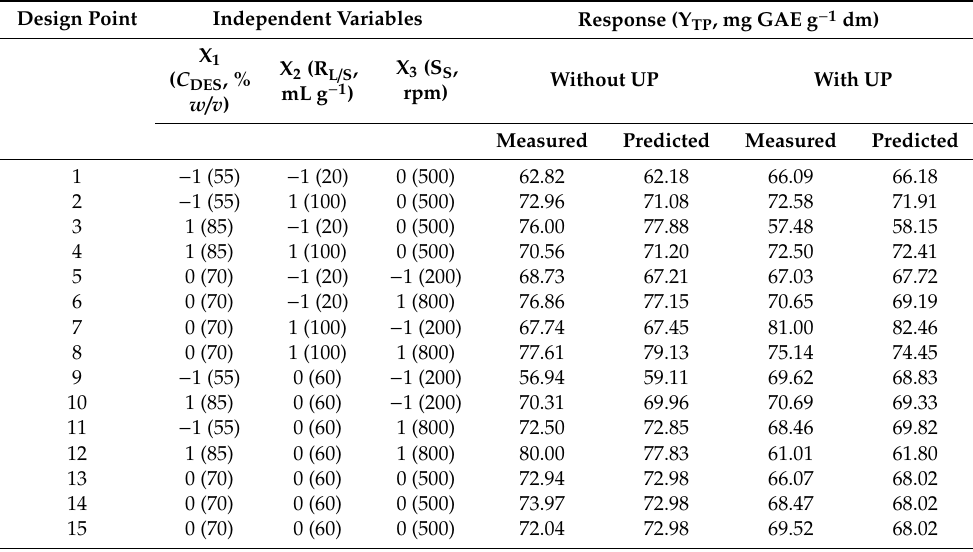
Table 4. Points of the experimental design considered, and measured and predicted values of the